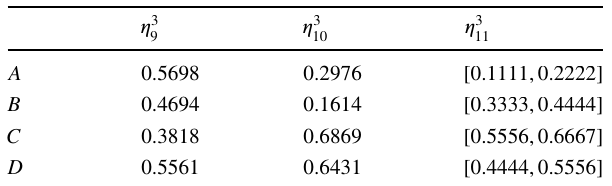
𝛽 3 under the ele- ij 4 × 3 ( )